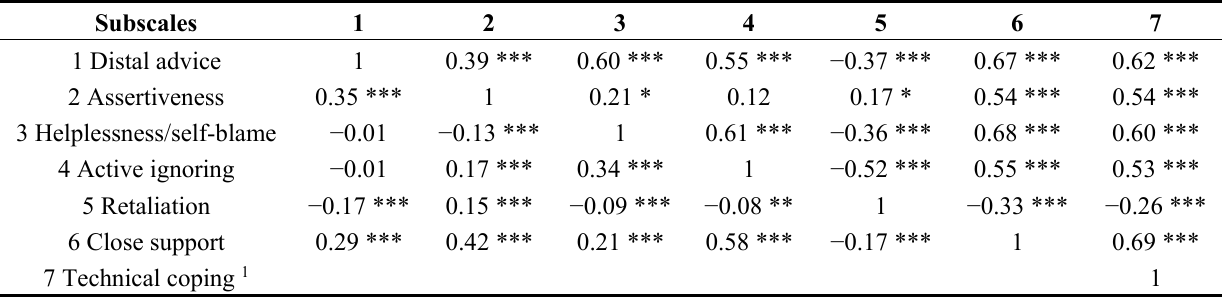
Table 4. Correlations between the subscales of the CWCBQ at Stage 3 ( N = 3970; below the diagonal) and Stage 4 ( N = 358; above the diagonal).